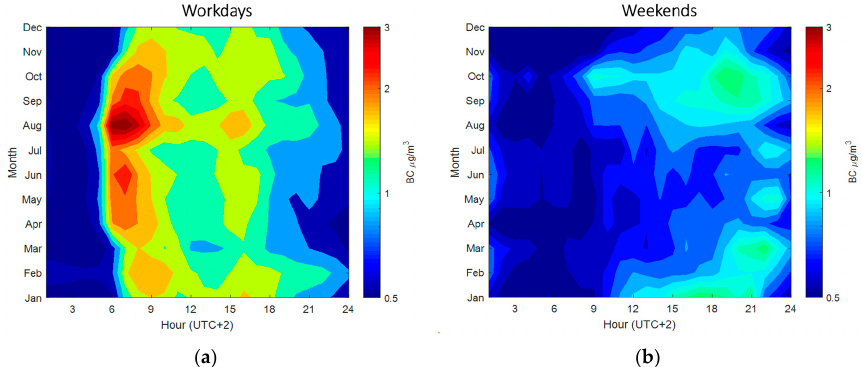
Figure 4. Contour plot of diurnal BC concentration (µg m –3 ) for each month in Mäkelänkatu street canyon. X-axis denotes the hour of day in UTC+2 and y-axis denotes months from January to December. ( a ) illustrates the variation in workdays and ( b ) represents weekends. Color bar is in logarithmic scale, where warm colors indicate higher concentrations and cold colors indicate lower concentrations.